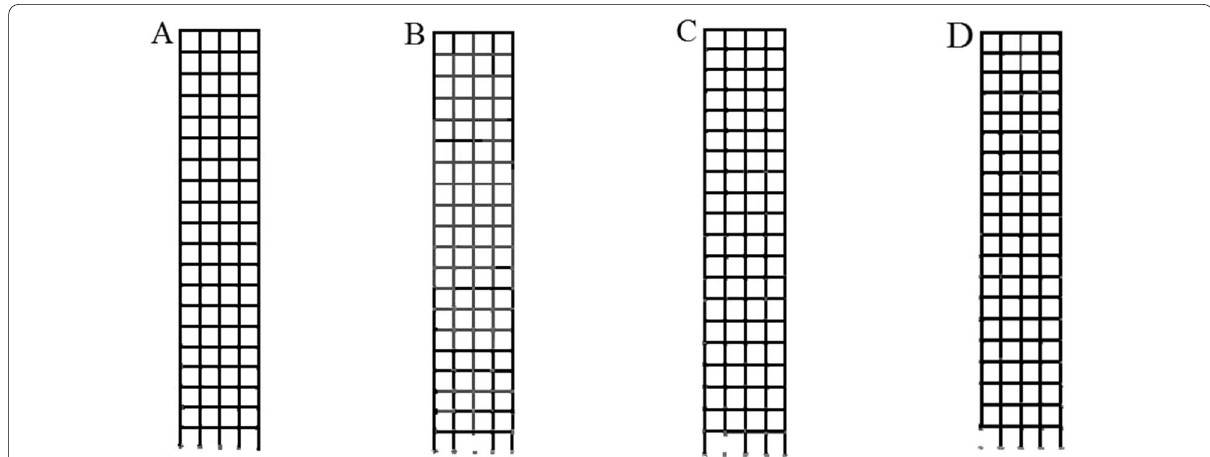
Fig. 4 The numerical models of the 20-story frames. A without column removal, and with B middle, C corner, and D edge column removal in SeismoStruct software.